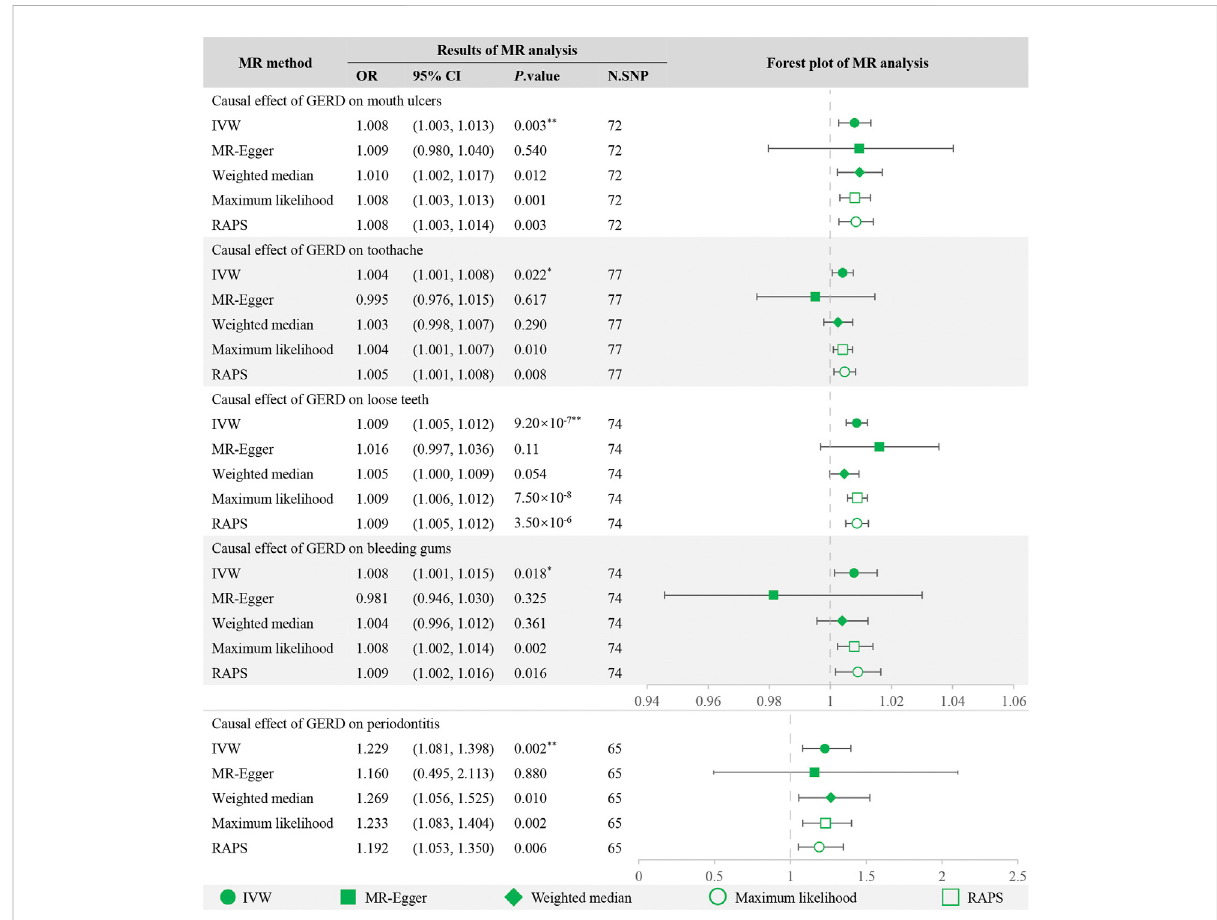
FIGURE 2 MR analysis of GERD with oral symptoms and the forest plot. **Signi fi cant estimate is de fi ned as IVW-derived p . value < 0.01. *Nominally signi fi cant is de fi ned as IVW-derived p . value < 0.05. OR, odds ratio. 95% CI, 95% con fi dence interval. IVW, inverse variance weighted. MR-Egger, Mendelian randomization Egger regression method. RAPS, robust adjusted pro fi le